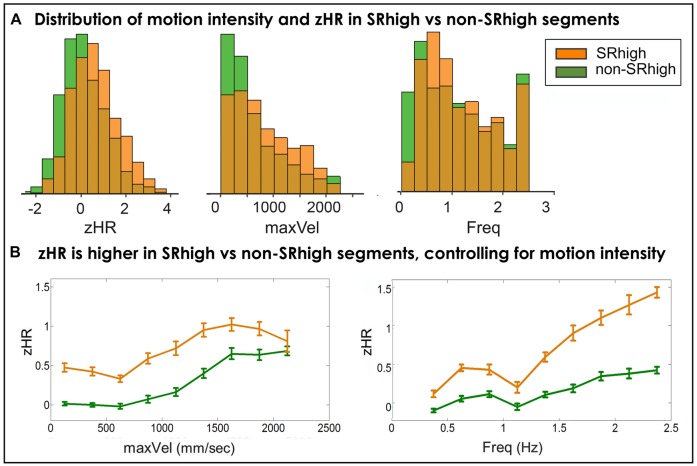
(A) Distributions of players’ HRs and motion intensity in SRhigh and non-SRhigh segments. In SRhigh segments compared to non-SRhigh segments, players demonstrate higher Z-normalized heart-rates, move at higher velocities and higher frequencies. (B) zHR in SRhigh vs. non-SRhigh segments, controlling for motion intensity. Average zHR is compared for SRhigh and non-SRhigh segments in same bins of maxVel (left) and Freq (right). zHR was higher in SRhigh segments than in non-SRhigh segment, for all frequency bins (Table 5) and for eight velocity bins (Table 6).